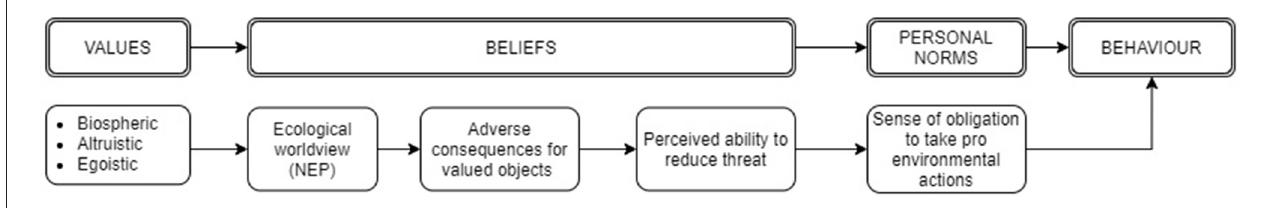
within organizations are different from those of household behaviors and the behavior of organizations has a huge environmental impact. All stakeholders may ignore it.